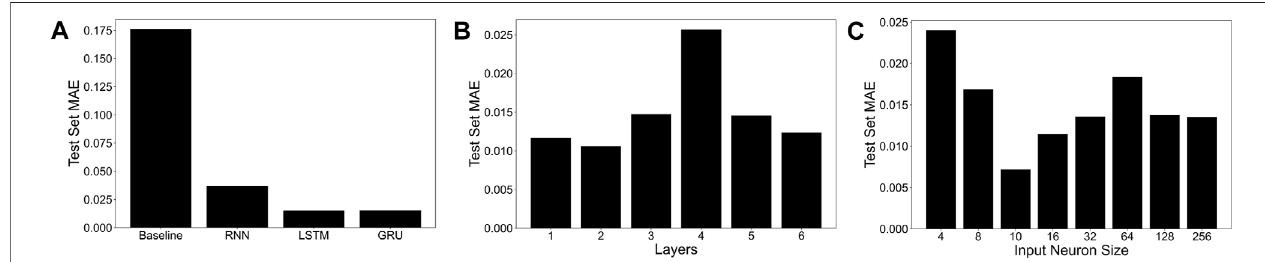
FIGURE 11 | Performance comparison of different trained neural network architectures based on the mean absolute error for the same test set. (A) shows a comparisonofbaselineperformancetoatraditional(orconventional)RNN,gatedrecurrentunit(GRU)andLSTM. (B) Showstheacomparisonoftheeffectofthenumber of LSTM layers on the model ’ s predictive performance. (C) Shows a comparison of the effect of the number of inputs on the model ’ s predictive